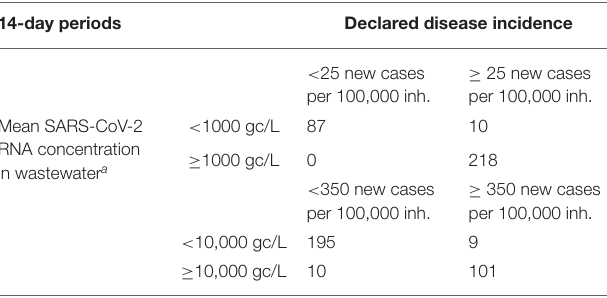
TABLE 1 | Wastewater RNA concentrations vs. disease incidences over 14-day